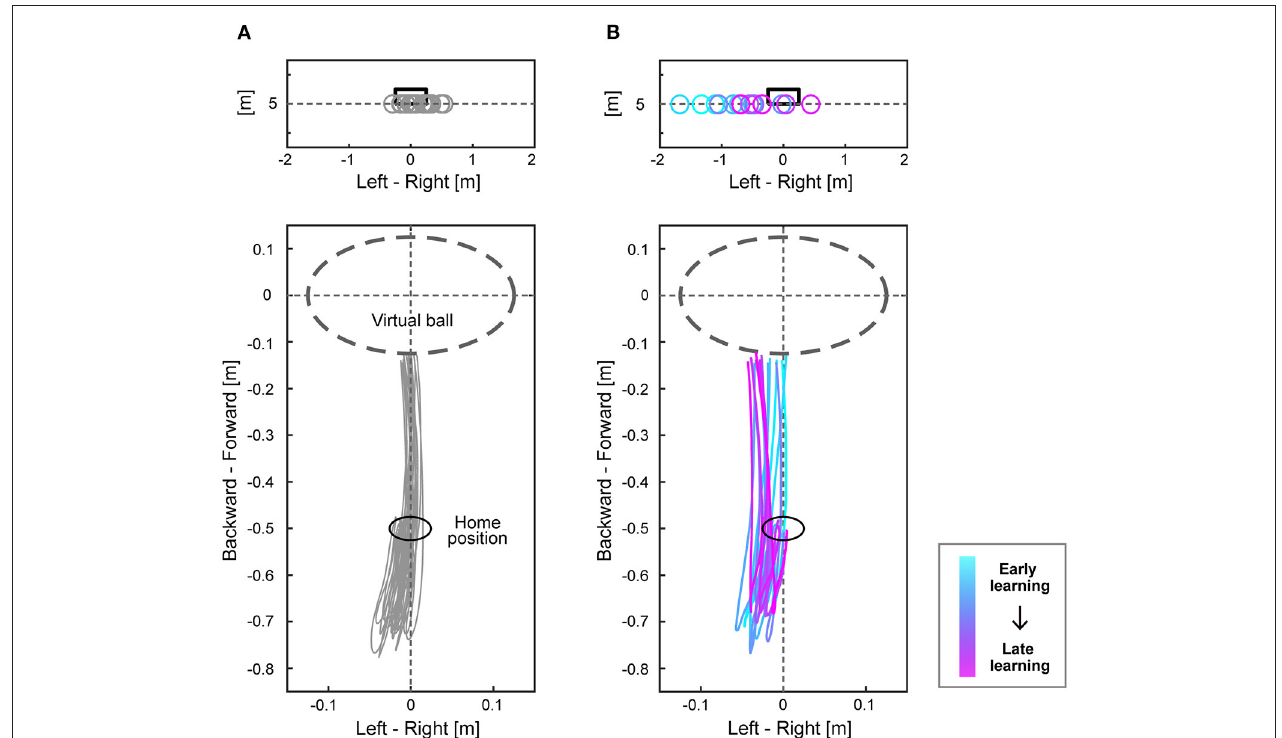
FIGURE 2 | Endpoints of the virtual ball and trajectories of the right foot. The upper figures of (A,B) show the endpoints of the virtual ball of a representative expert subject of the counterclockwise group. The black box represents the target, and each circle shows endpoints of the virtual ball at each trial. The lower figures of (A,B) show trajectories of the right foot on the horizontal plane when the participant swung their right foot backward from the home position and kicked the virtual ball. The dashed line circle represents the location of a virtual ball. (A) shows the results during the last 20 trials of the baseline period, and (B) shows each result of every 10 trials during the perturbation period (16 trajectories). The color changes from cyan to magenta as the trial proceeds.